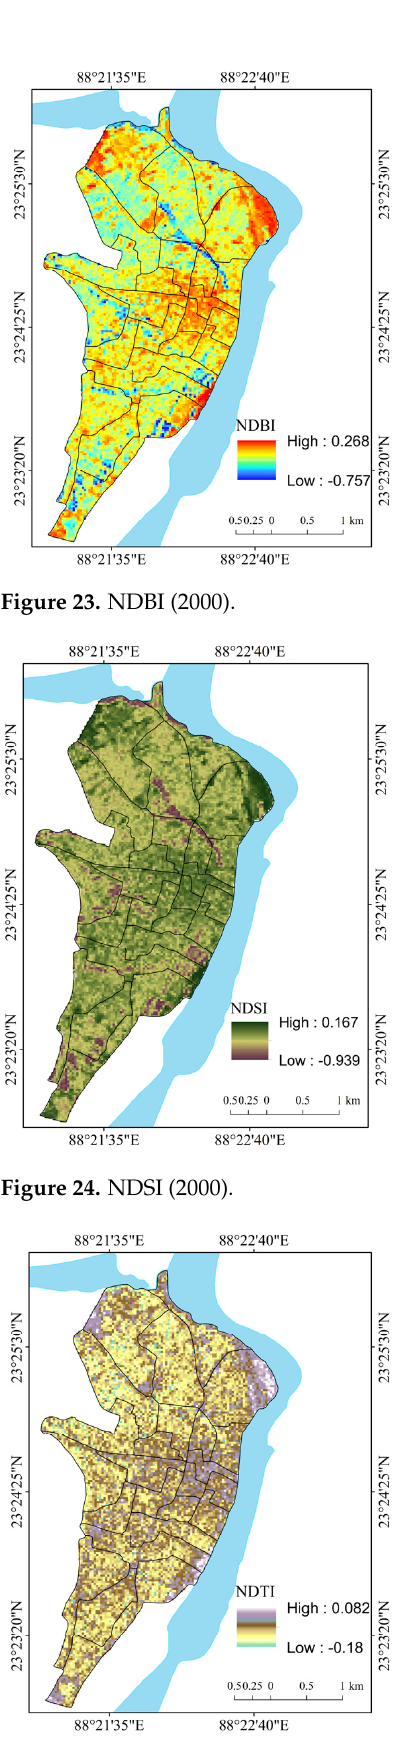
Figure 25. NDTI Figure 25. NDTI (2000).